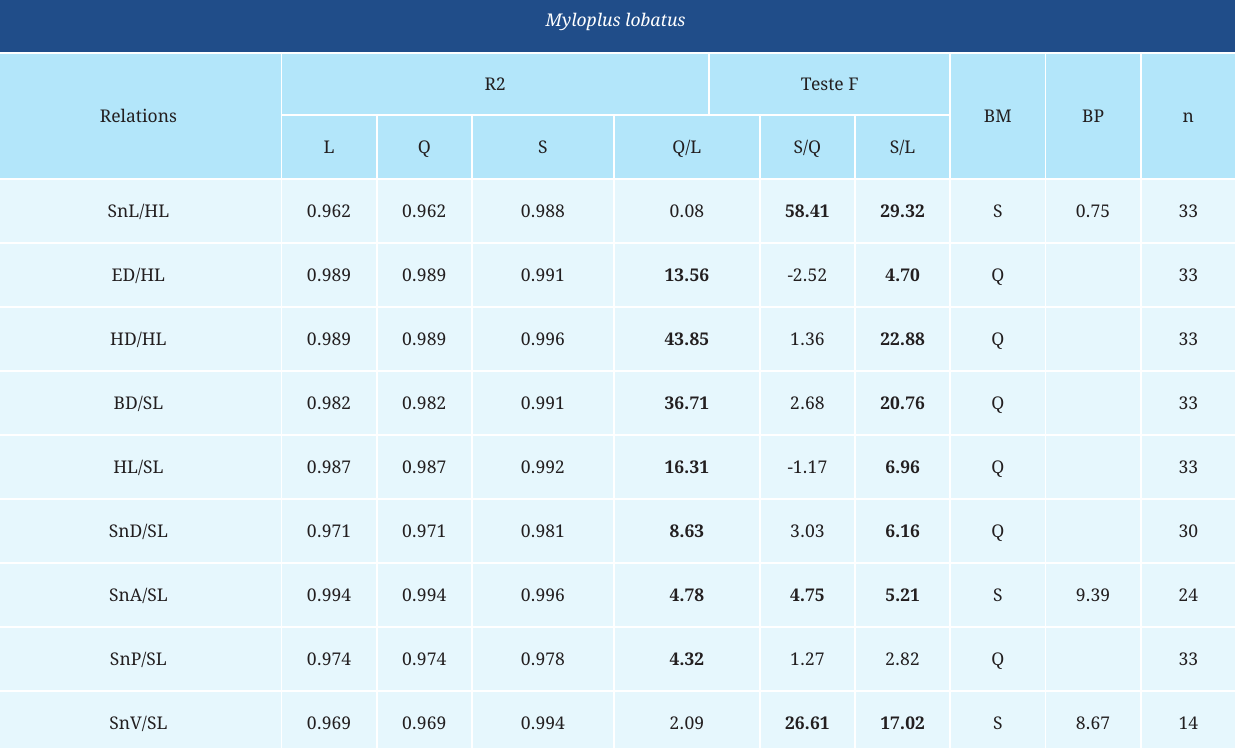
TABLE 4 | Values of quadratic (Q) and piecewise (S) regression analyses of morphometric variables in relation to head length (HL) and standard length (SL) of larvae and juveniles of Myloplus lobatus . R² = coefficient of determination. BM = best model, BP = breaking point (mm), n = number of analyzed individuals. Bold values represent a significant difference (p <